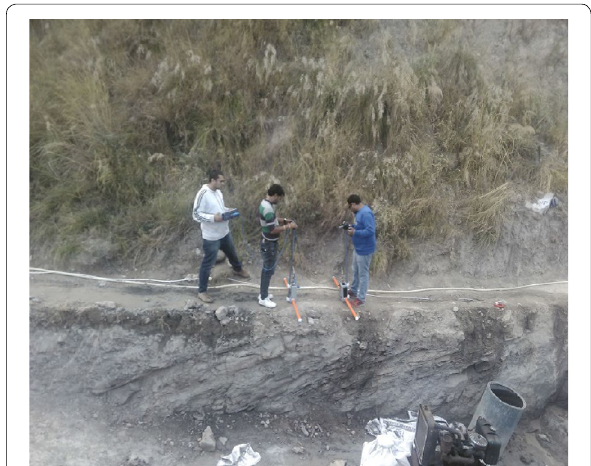
Fig. 2 A typical set of GPR testing conducted at Mansadevi